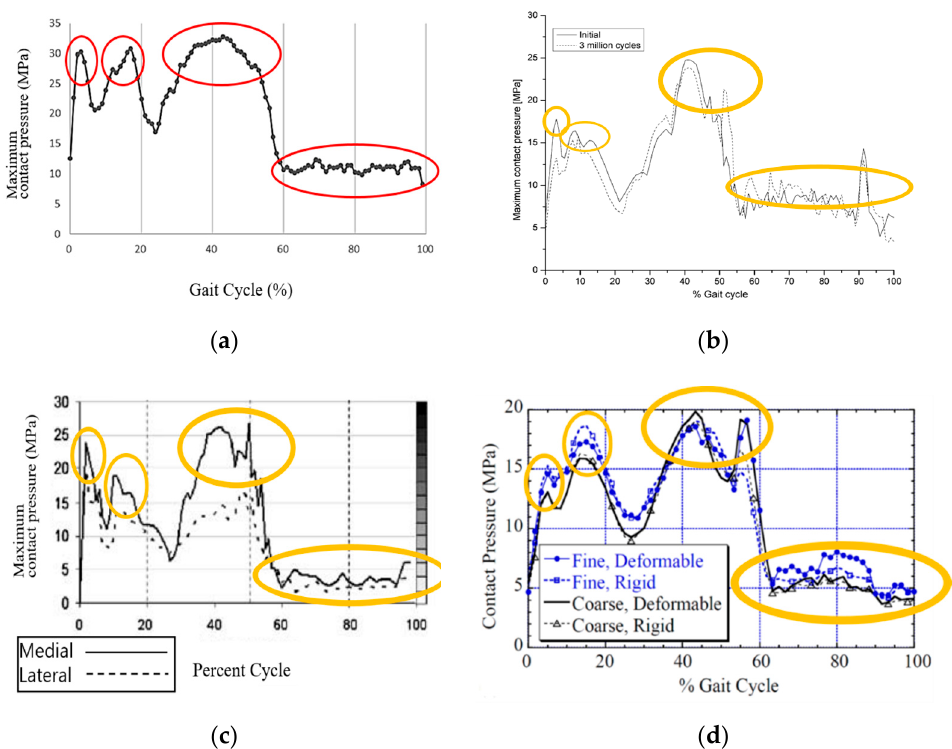
Figure 10. Tendency of maximum contact pressure: ( a ) present study; ( b ) Abdelgaied et al. (reprinted with permission from ref. [11]. Copyright 2011 Elsevier); ( c ) Willing et al. (reprinted with permission from ref. [16]. Copyright 2008 Springer Nature); ( d ) Halloran et al. (reprinted with permission from ref. [33]. Copyright 2011 Elsevier).